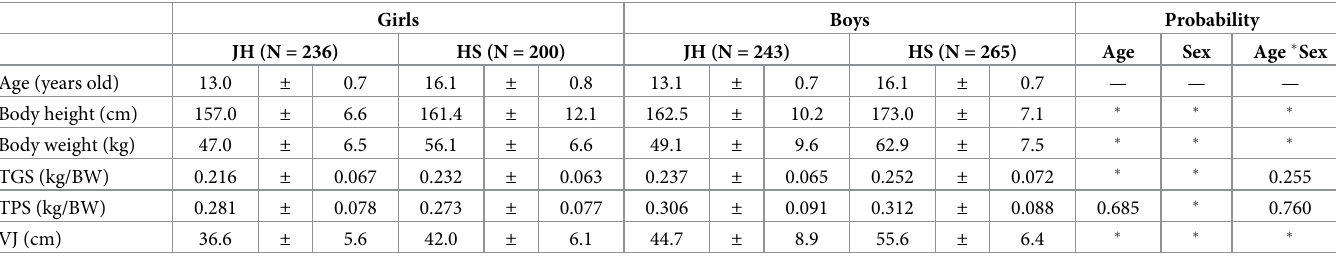
Table 1. Physical properties, toe muscular strengths, and jump performance of each group.